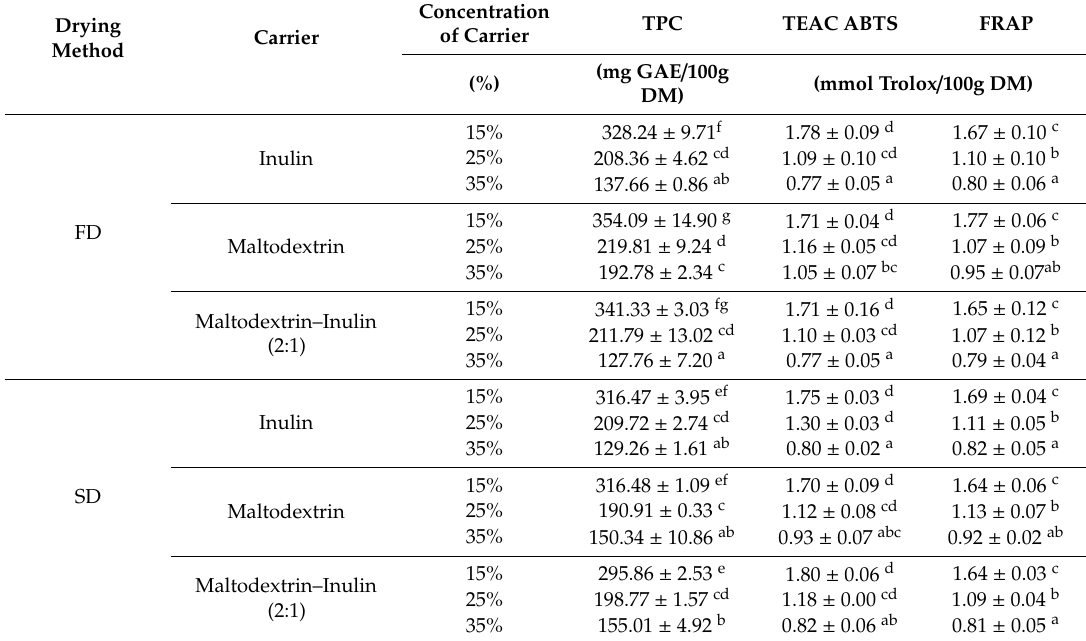
Table 3. The content of total polyphenolic compounds (TPC) and antioxidant capacity (Trolox equivalent gained by freeze- and spray-drying ( n = 2, average ± standard